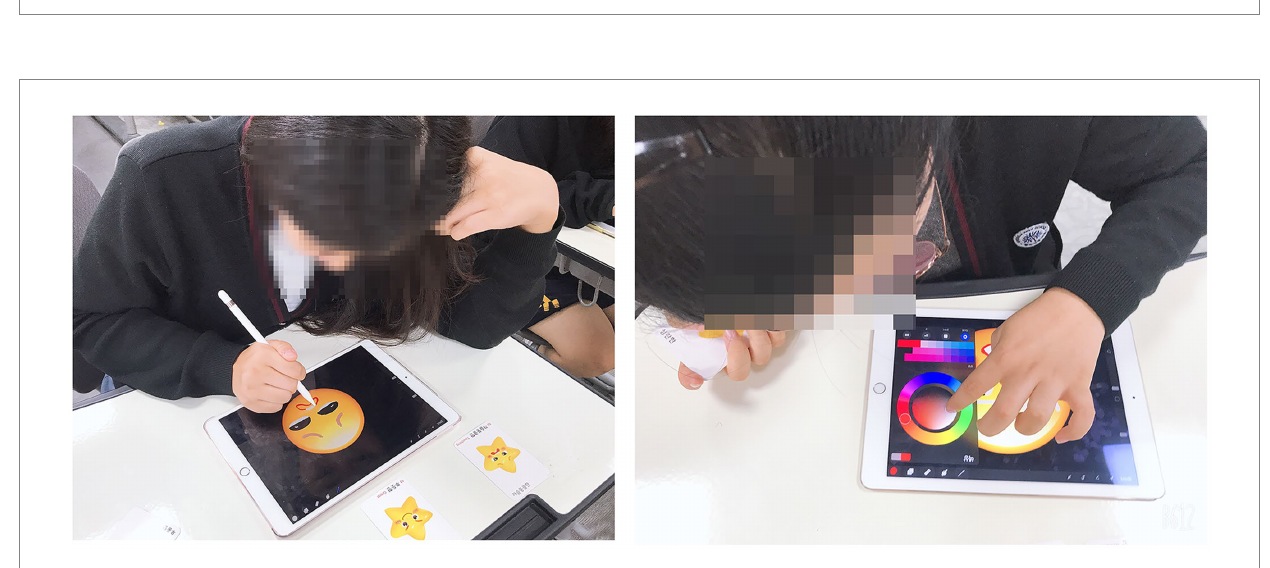
FIGURE 5 Process of iPad drawing (Apple pencil drawing and finger